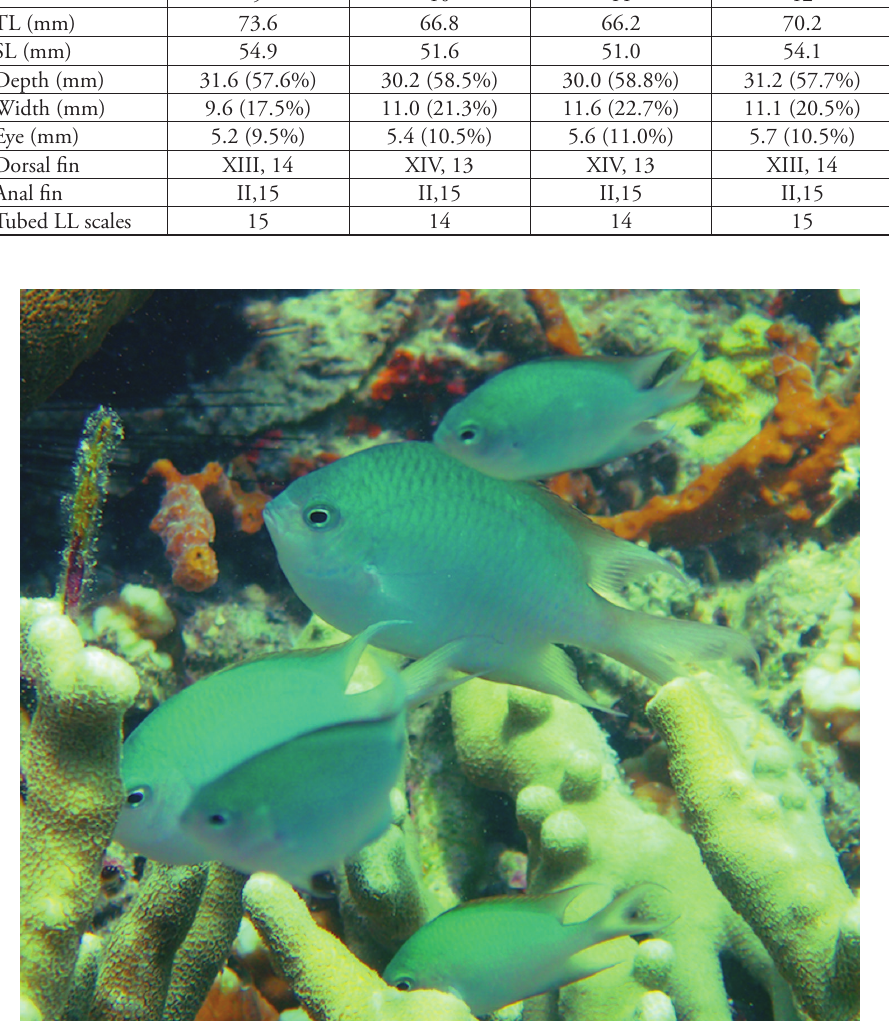
Figure 3. Altrichthys alelia in its natural environment, near a common nesting substrate, the coral Porites cylindrica. line scales easily distinguish A. curatus (17–18) and A. azurelineatus (10-14). Counts for A. alelia are most similar to and overlap A. azurelineatus counts, but exhibit a higher mode